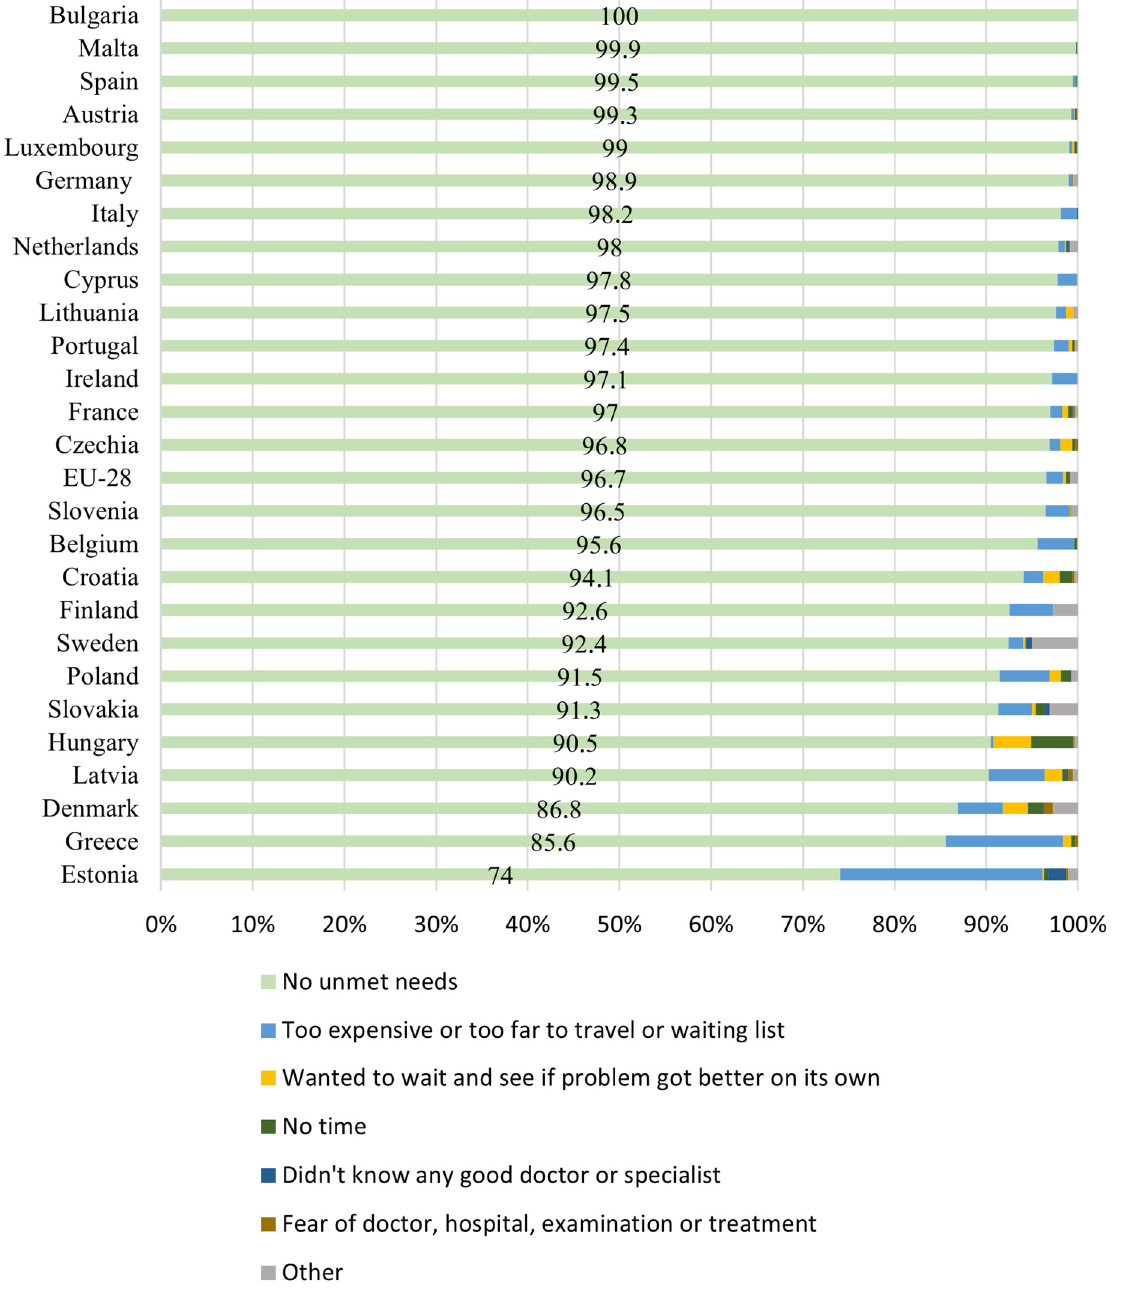
Figure 4. Self-reported unmet needs for medical examination by main reason declared, foreign population in European countries, 2019 (%). Source: Eurostat—last data extracted on 5 December 2021 (online data code: HLTH_SILC_29).